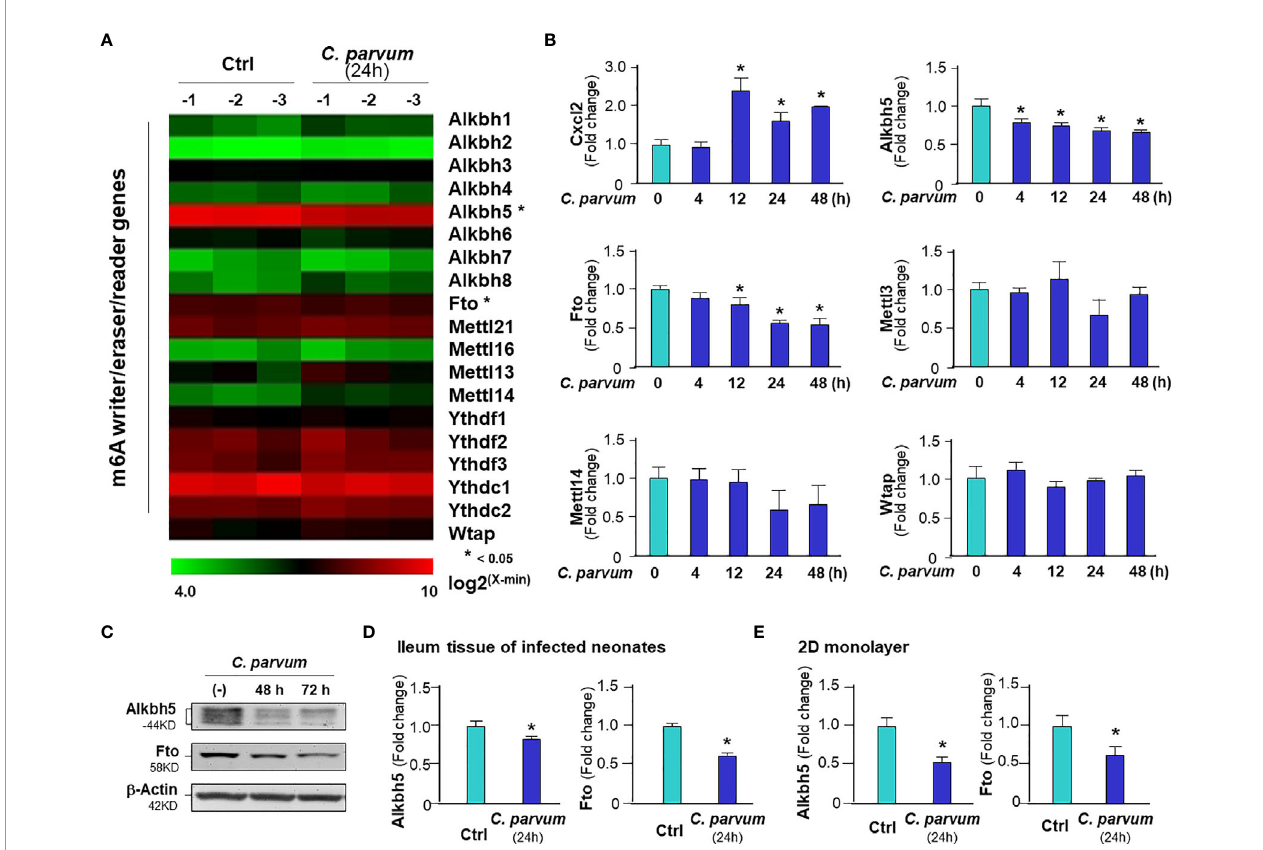
FIGURE 2 | Downregulation of Alkbh5 and Fto in intestinal epithelial cells C. parvum infection. (A) Heatmaps showing expression pro fi le of key genes involved in the m 6 A RNA methylation machinery in IEC4.1 cells following C. parvum infection. Cells were exposed to C. parvum infection for 24 h followed by genome-wide array analysis. (B) Dynamics of Alkbh5 and Fto downregulation in IEC4.1 cells following C. parvum infection. IEC4.1 were exposed to C. parvum infection for 4-48 h and RNA expression levels of Alkbh5 and Fto were validated by using real-time quantitative PCR. Expression levels of Cxcl2 (as a positive control), Mettl3, Mettl14 and Wtap were also measured. (C) Decreased abundance of Alkbh5 and Fto proteins in IEC4.1 cells following C. parvum infection. IEC4.1 were exposed to C. parvum infection for 48-72 h and expression levels of Alkbh5 and Fto at the protein level were validated using Western blot. b -Actin was also blotted for internal control. Representative gels were shown. (D) Downregulation of Alkbh5 and Fto in murine intestinal epithelium following C. parvum infection in vivo . Neonates of mice at 5 days of age received C. parvum administration by oral gavage and intestinal ileum epithelium were isolated after infection for 24h. Expression levels of expression levels of Alkbh5 and Fto were measured. (E) Downregulation of Alkbh5 and Fto in 2D murine intestinal epithelial monolayers following C. parvum infection ex vivo . Data represent three independent experiments. *p<.05 vs the non-infected